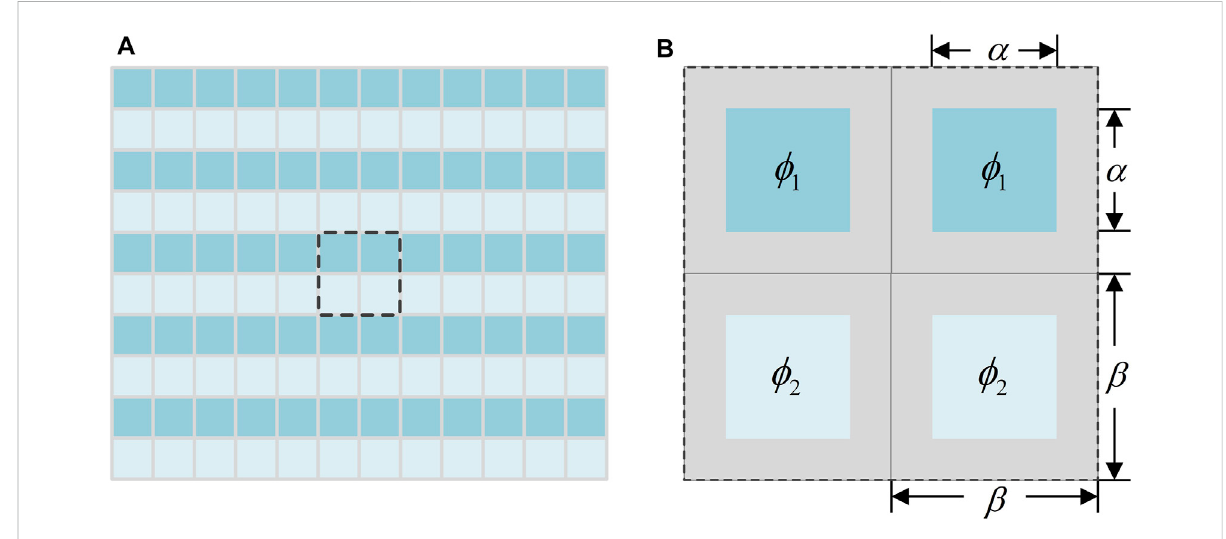
FIGURE 3 (A) SLM which has been loaded with a rectangular phase grating and (B) the detailed phase